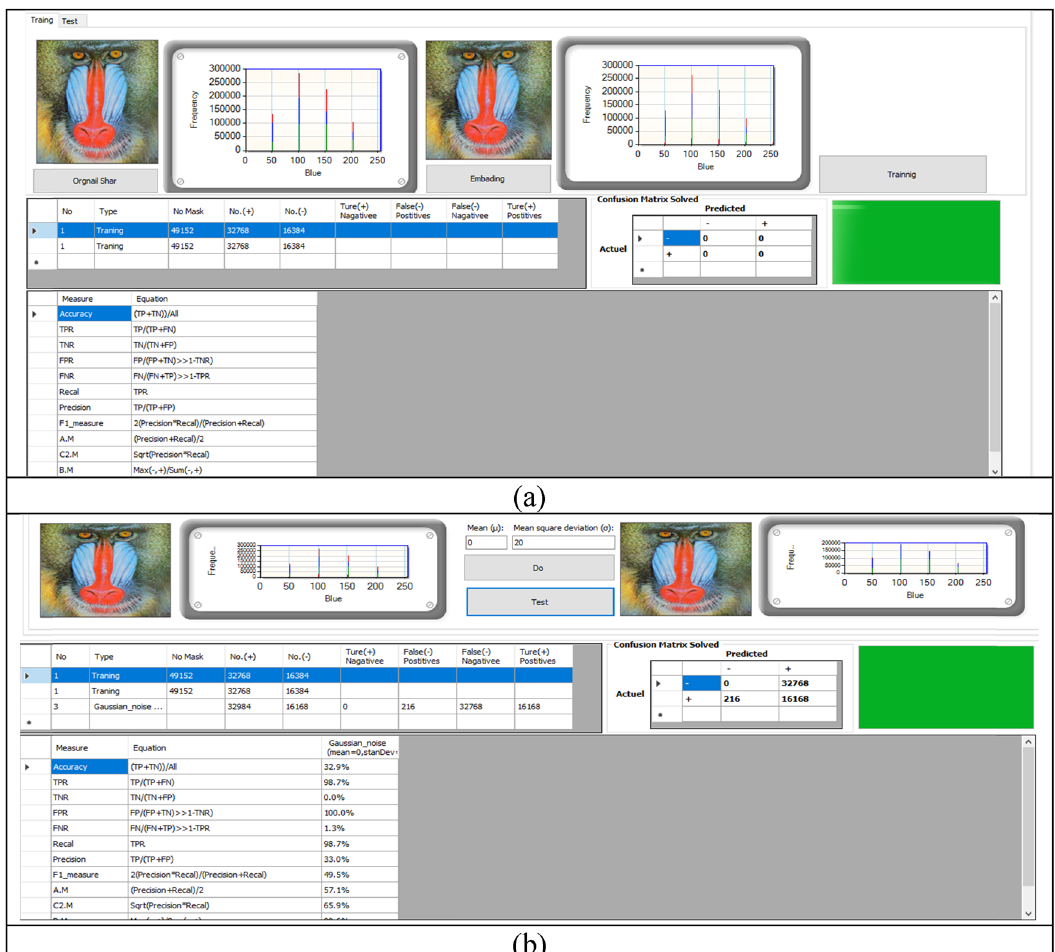
Figure 13: The interface of Gaussian attack initial parameters, mean ( μ ) = 0 and standard deviation ( std ) = 20: ( a ) interface of the training process and ( b ) interface of the testing